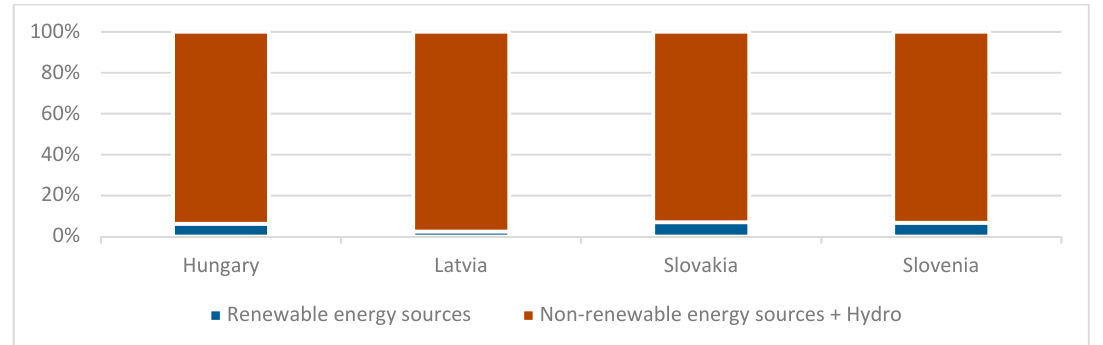
Figure 16. Energy sources in the countries of group A in 2016.